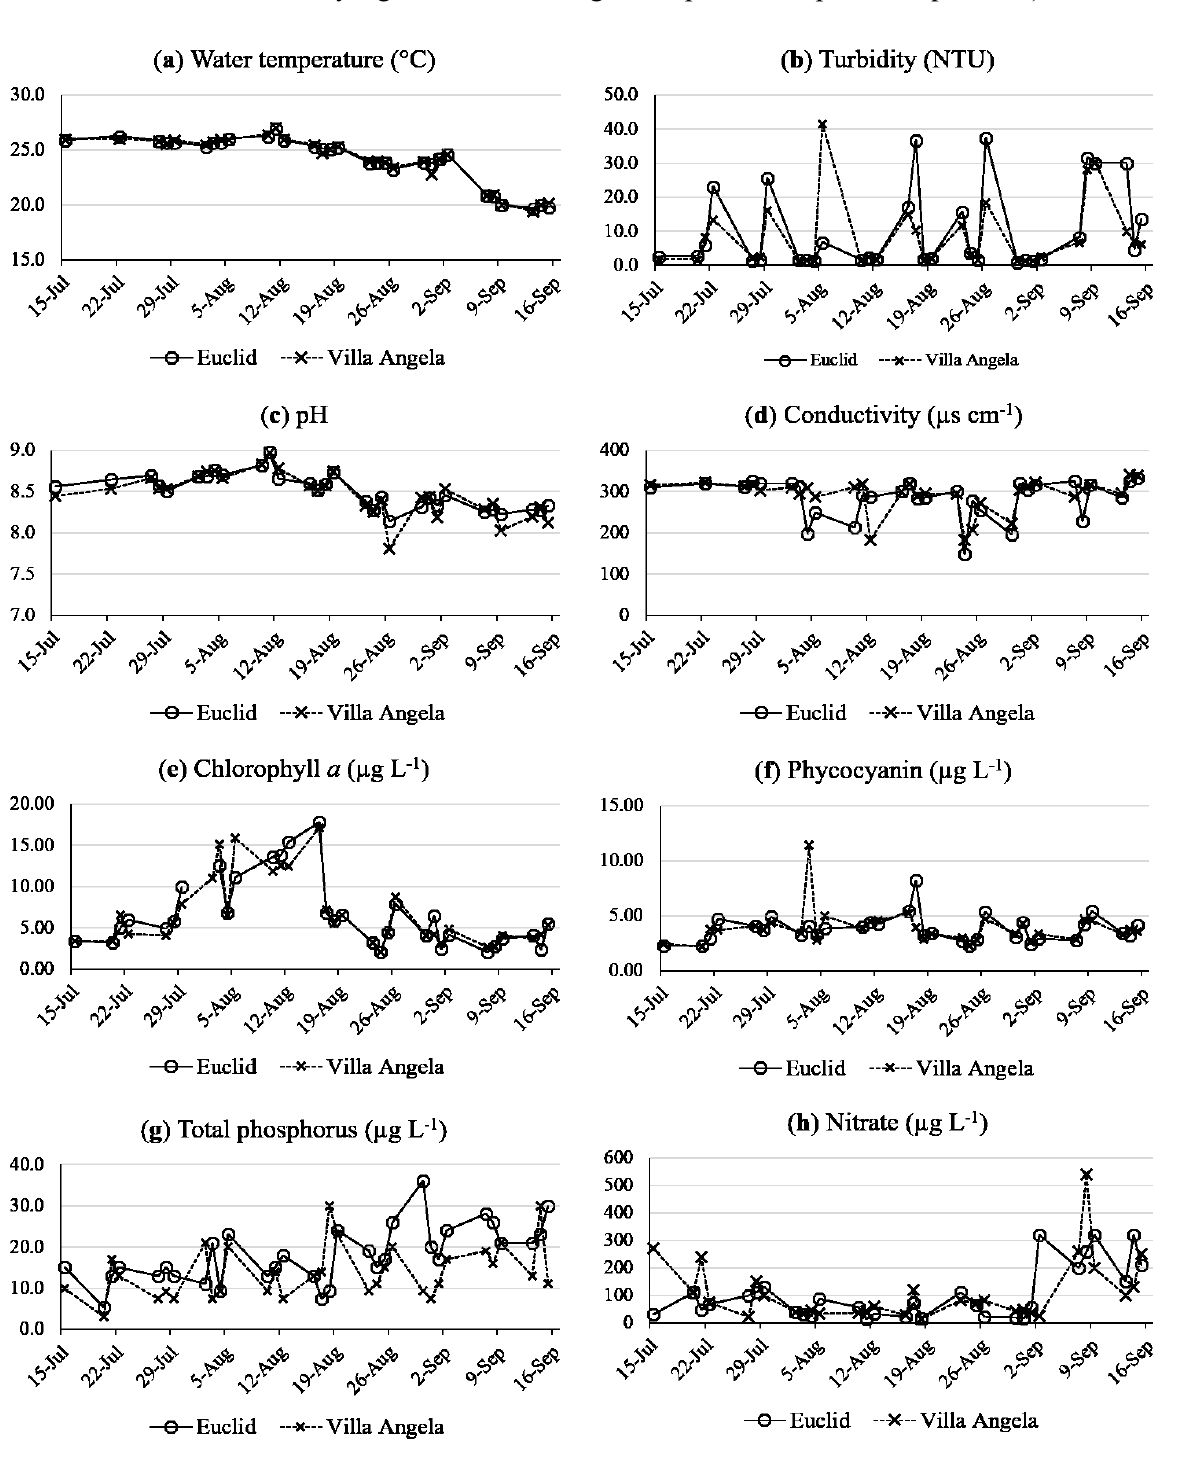
Figure 2. Profiles of water quality parameters at Euclid and Villa Angela beaches from July to September in 2010: ( a ) water temperature; ( b ) turbidity; ( c ) pH; ( d ) conductivity; ( e ) chlorophyll a ; ( f ) Phycocyanin; ( g ) total phosphorus; ( h )